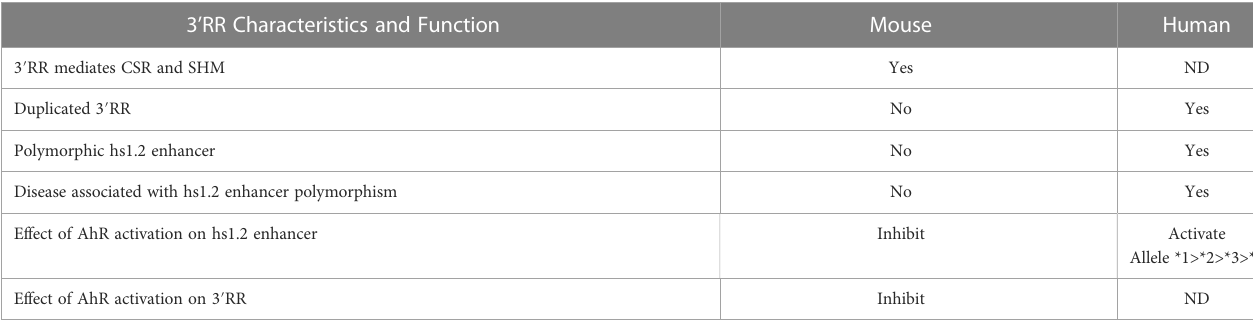
TABLE 4 Comparison of mouse versus human 3 ’ RR characteristics and effect of AhR activation. 3 ’ RR Characteristics and